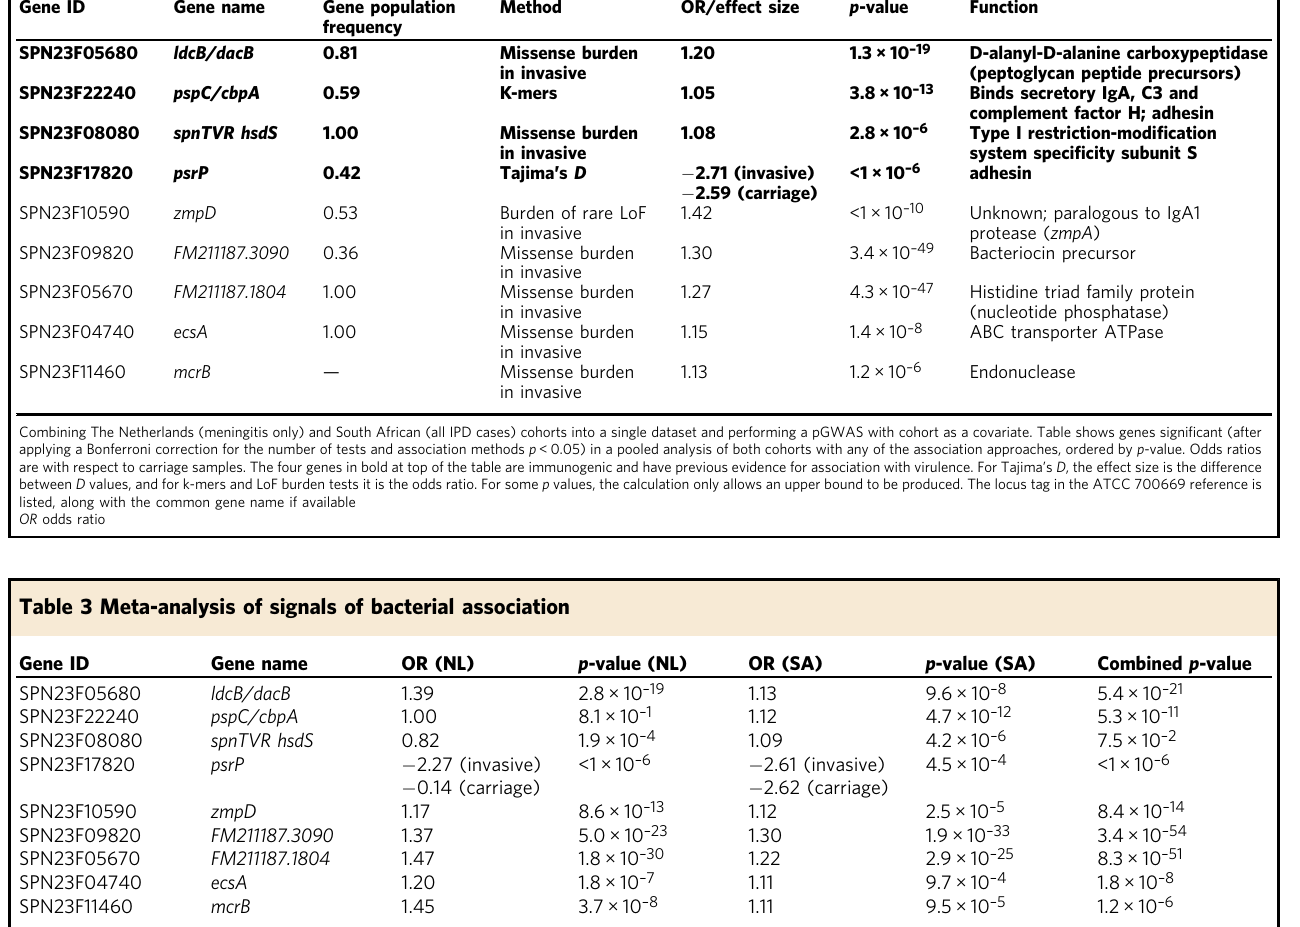
Table 2 Signals of bacterial association in a pooled analysis Gene ID